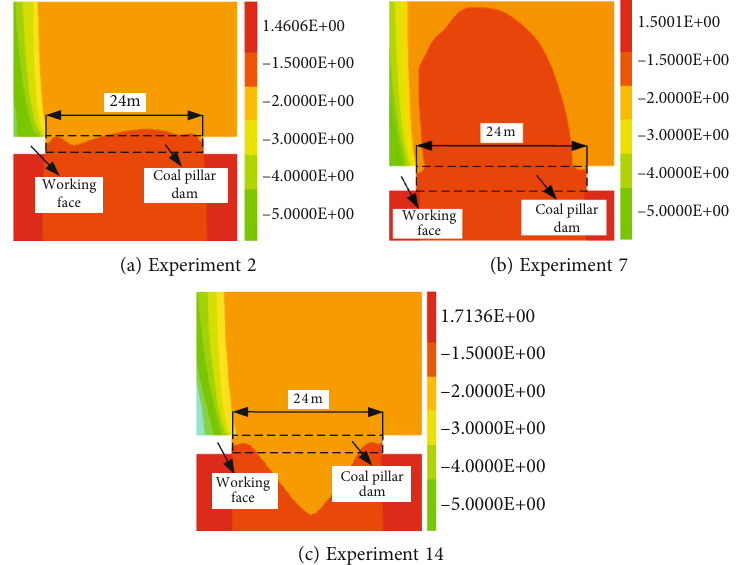
Figure 8: Vertical deformation cloud diagram of partial coal pillar. Table 2: Simulation